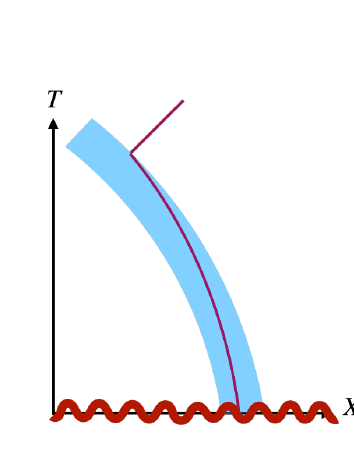
Figure 4. The trajectory of an outgoing wave packet with a shift ∆ U (3.12) due to its interac- tion with the collapsing matter (thick blue strip).